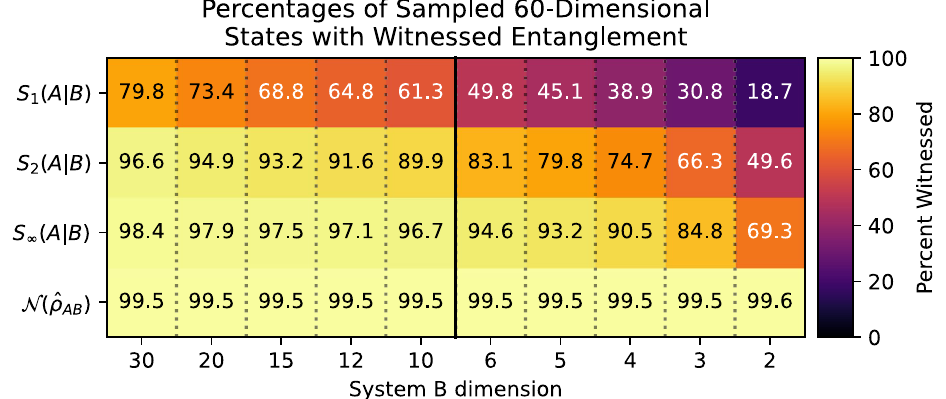
Figure 3. Plot showing percentages of 60-dimensional joint systems sampled according to the uniform-purity ensemble, whose entanglement was witnessed by comparing different forms of joint and marginal entropies, and by the negativity of the partial transpose. These systems were bipartitioned into subsystems of dimensions D A and D B respectively, such that D A D B 60 . Starting with 10 6 random diagonal density matrices, =